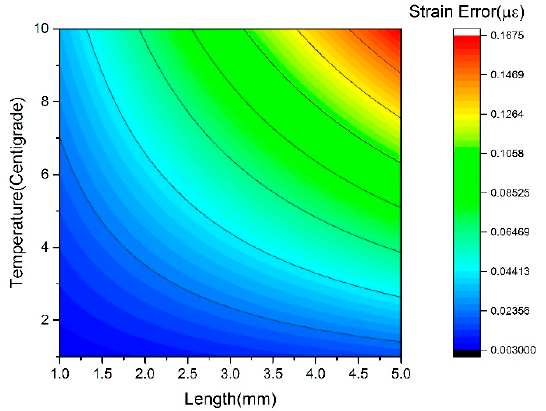
Figure 9. The strain error induced by temperature fluctuations.